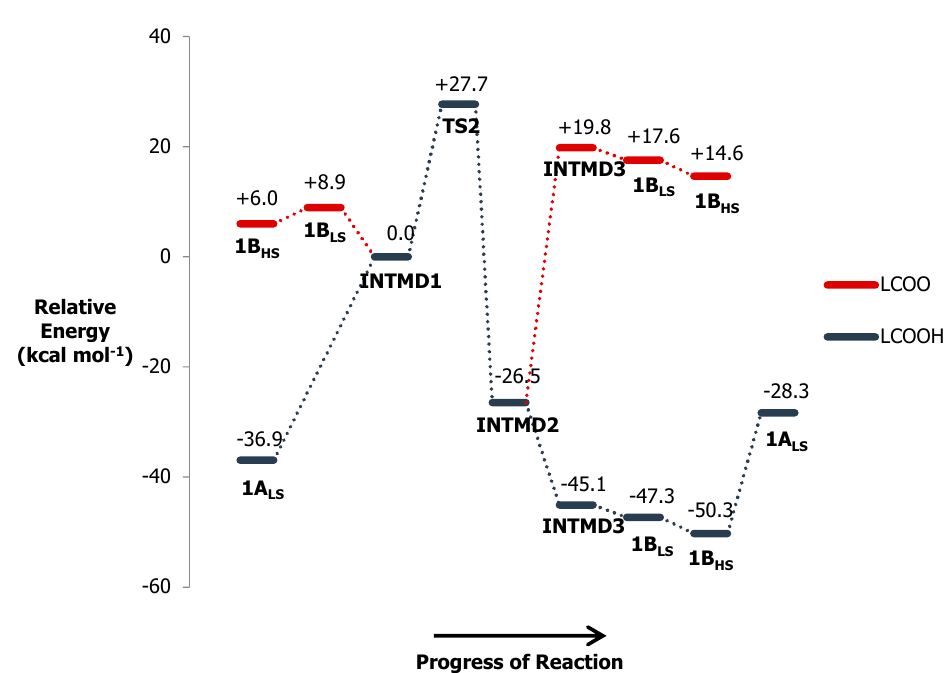
Figure 9. Reaction energy diagram of ABTS oxidation with H 2 O 2 catalyzed by Ni(II)–PyMACs. 1A/1B was chosen as the model catalyst pair. Individual energies of participating species (H 2 O 2 , ABTS, ABTS + · , HO · , HO − , H 3 O + , and H 2 O) have been incorporated accordingly in all quoted relative energies.